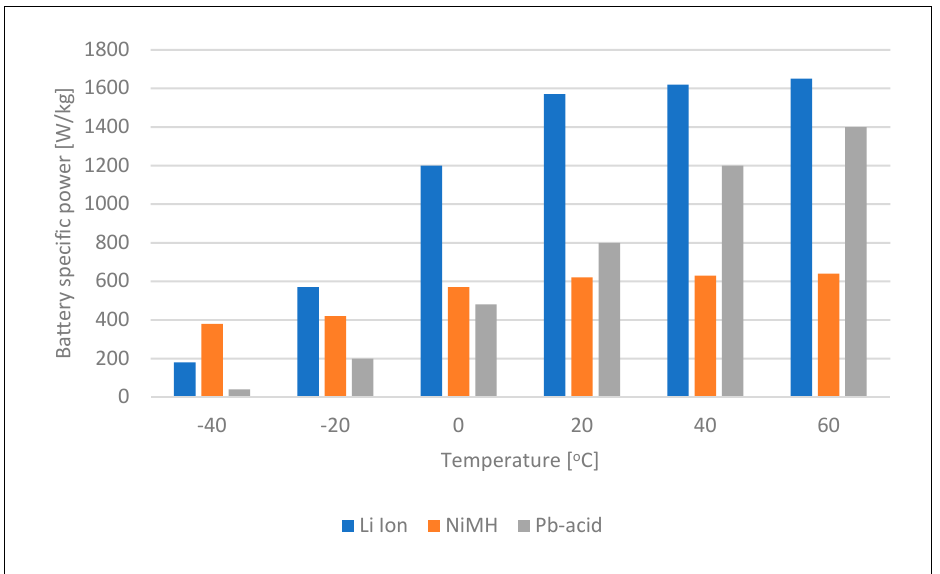
Figure 6. Influence of temperature on the energy performance of different types of batteries [43].